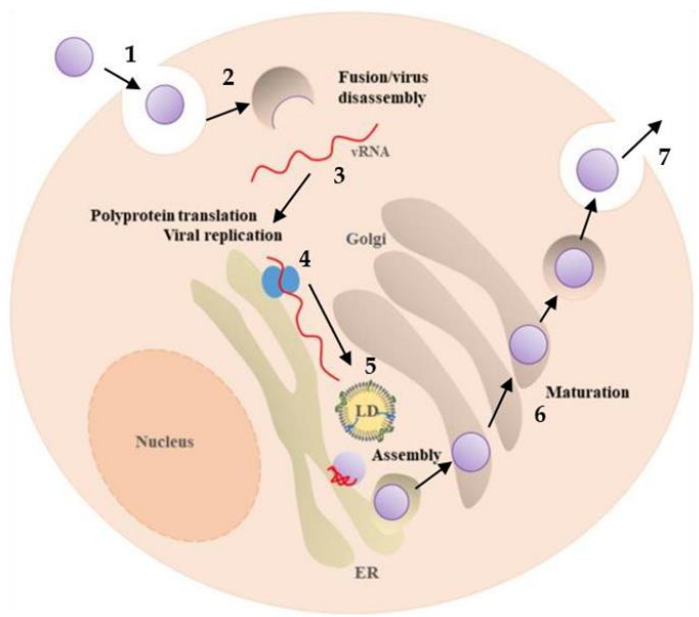
Figure 3. Viral life cycle. After entering host cells by clathrin-mediated endocytosis (1), membrane fusion of the viral envelope and the cell membrane occurs (2). Viral genome is released into the cytoplasm (3) and translated into a single polyprotein, later cleaved into the three structural and seven non-structural proteins (4). Next, replication occurs surrounding the endoplasmic reticulum (ER) and lipid droplets (LDs) (5), followed by viral packaging and assembly to form infectious viral particles (6), which are then released through exocytosis (7). The three flaviviruses discussed here share similar virion structure and mode of infection, besides being also all mosquito-borne. Adapted with permission from Ref. [4]. Copyright 2020 Silva, N.M.; Santos, N.C.; Martins, I.C.